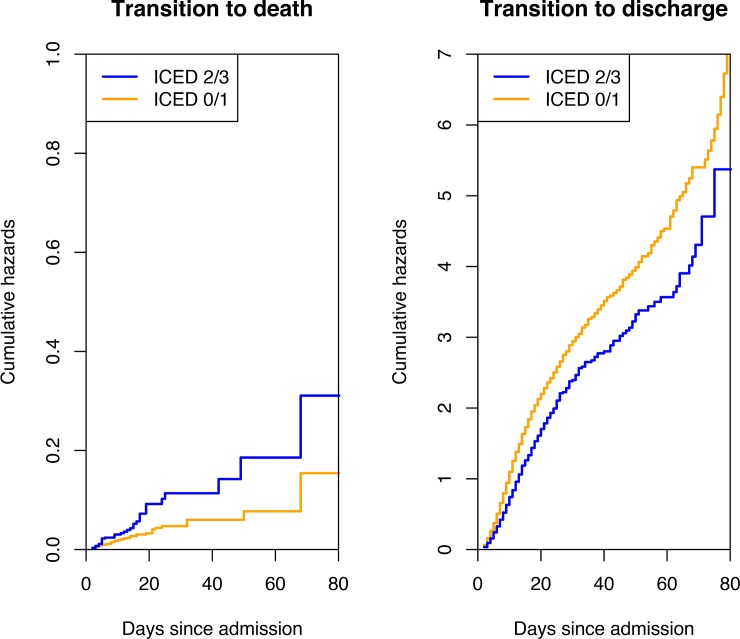
Cumulative hazards stratified by the ICED scores in the competing risk model.Orange lines indicated lower ICED group (n = 4153) whereas blue lines represented higher ICED group (n = 844). Higher ICED group had higher cumulative hazards for transition-to-death and lower cumulative hazards for transition-to-discharge compared with lower ICED group.